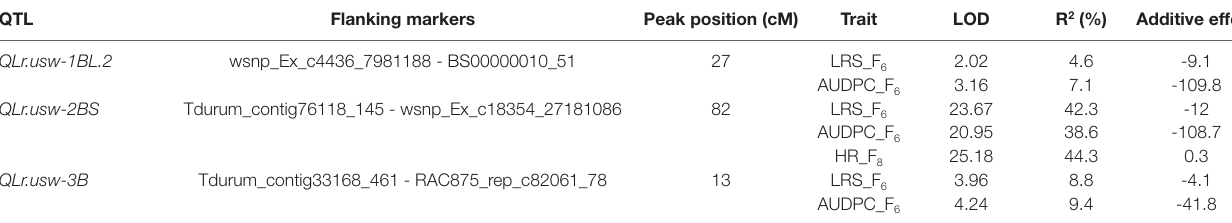
TABLE 5 | Leaf rust resistance QTL detected by CIM in the Saragolla/ATRED #2 population. QTL Flanking markers Peak position (cM)